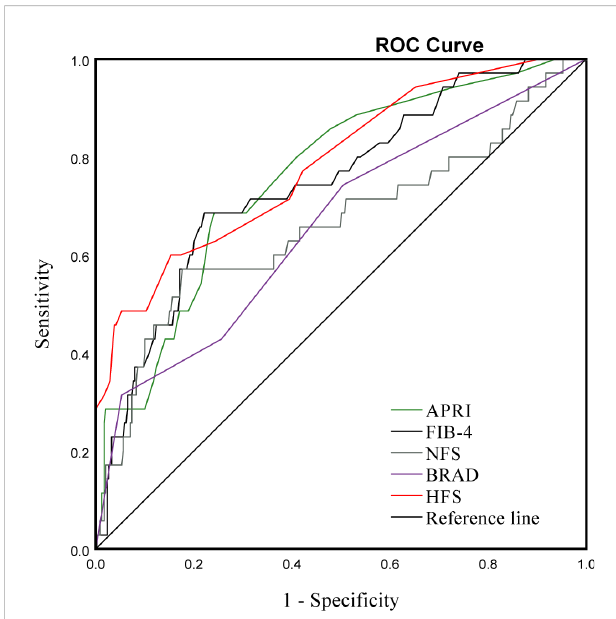
FIGURE 3 ROC curve for APRI, FIB-4, NFS, BARD and HFS in bariatric surgery patients with and without signi fi cant fi brosis.